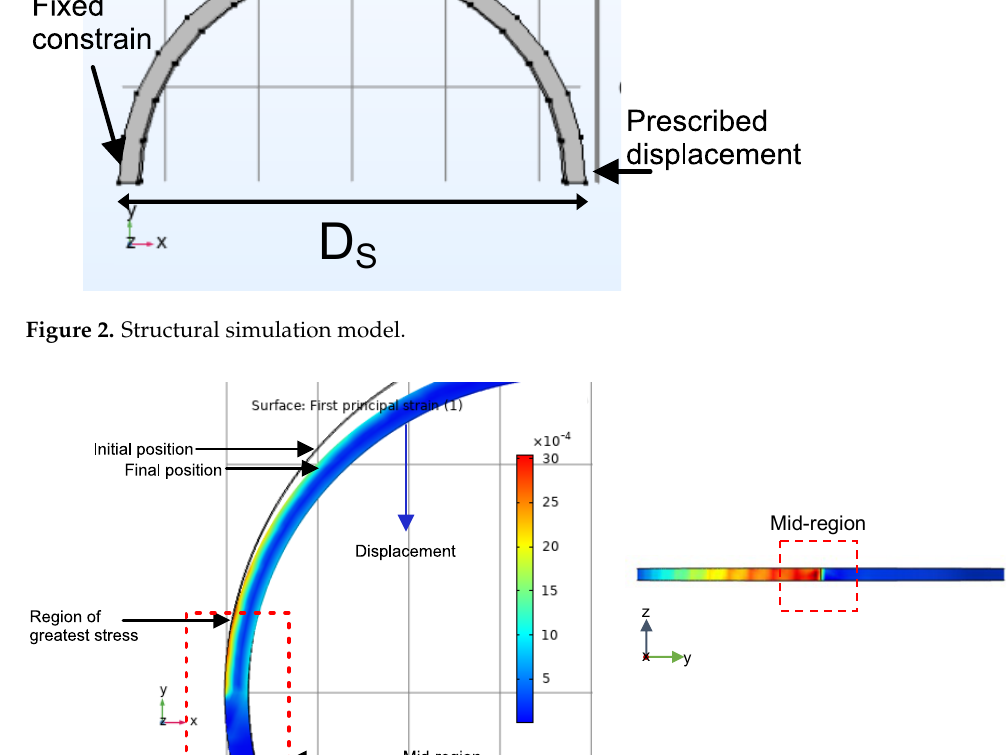
Figure 3. Static structural analysis of the piece without supports based on FEM.